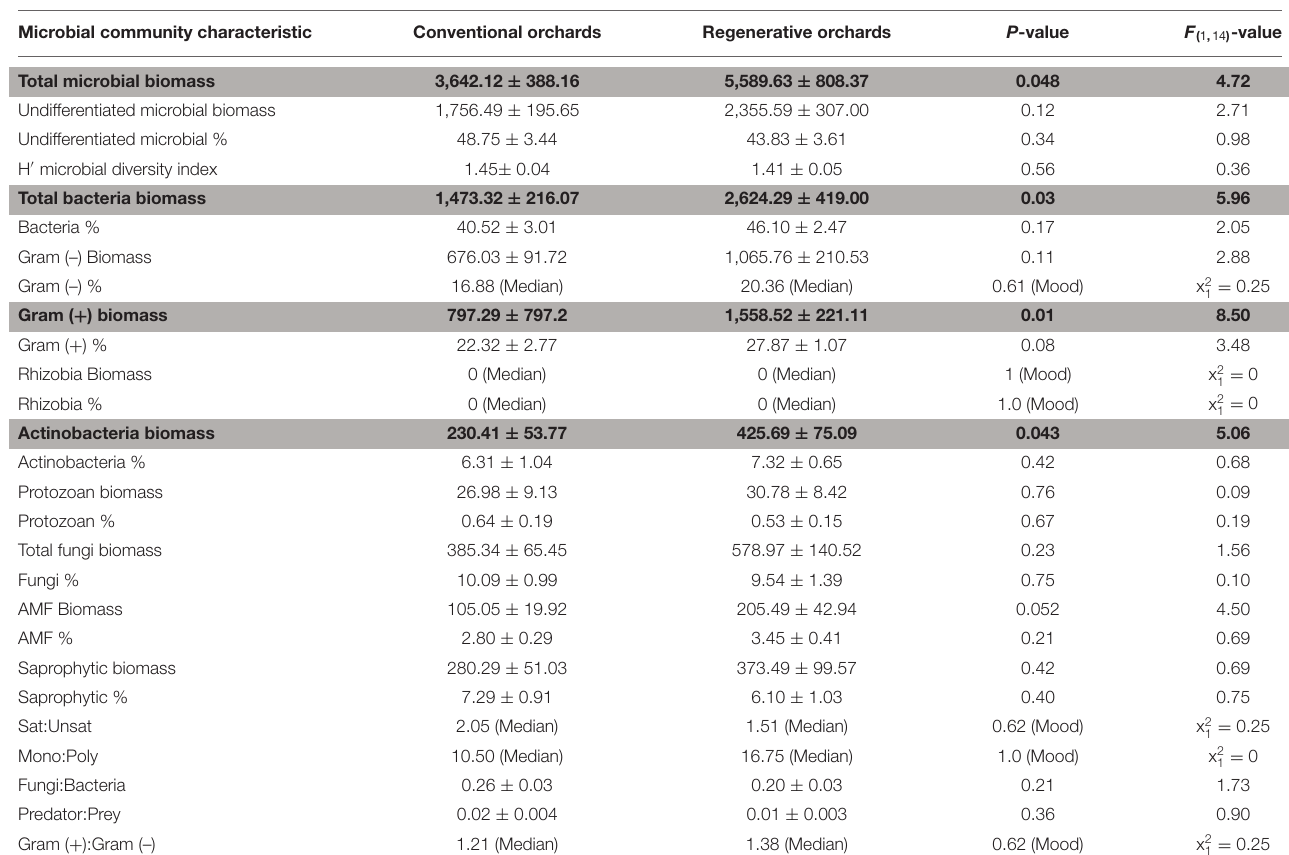
TABLE 4 | The soil microbial community in regenerative and conventional almond orchards. Microbial community characteristic Conventional orchards Regenerative